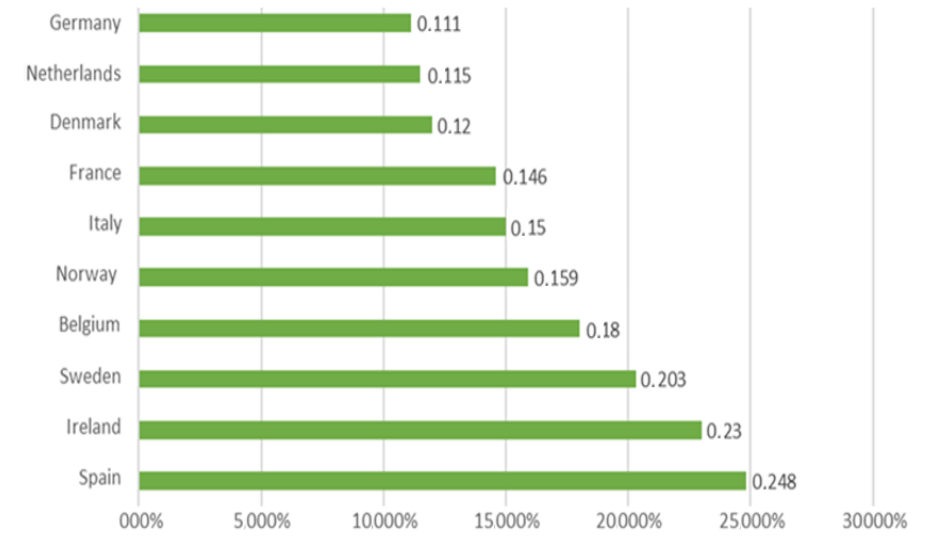
Figure 6. The countries with the highest growth of the organic market 2015 (market growth in %). Source: FiBL-AMI Surveys 2017.